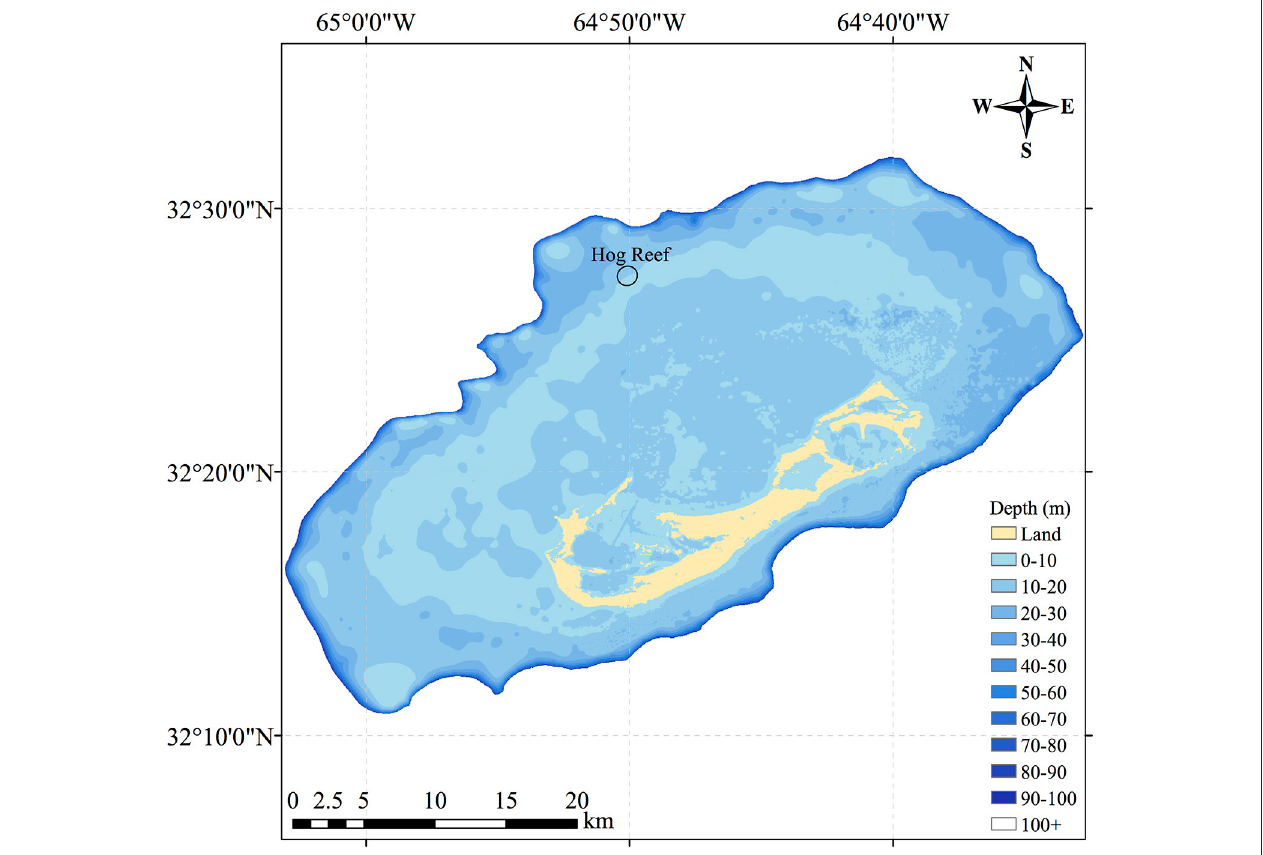
FIGURE 1 | Map of the Bermuda coral reef platform showing Hog Reef, located on the northwestern portion of the rim reef. The black ellipse at Hog Reef represents the estimated effective footprint for the benthic community influence on the overlying seawater